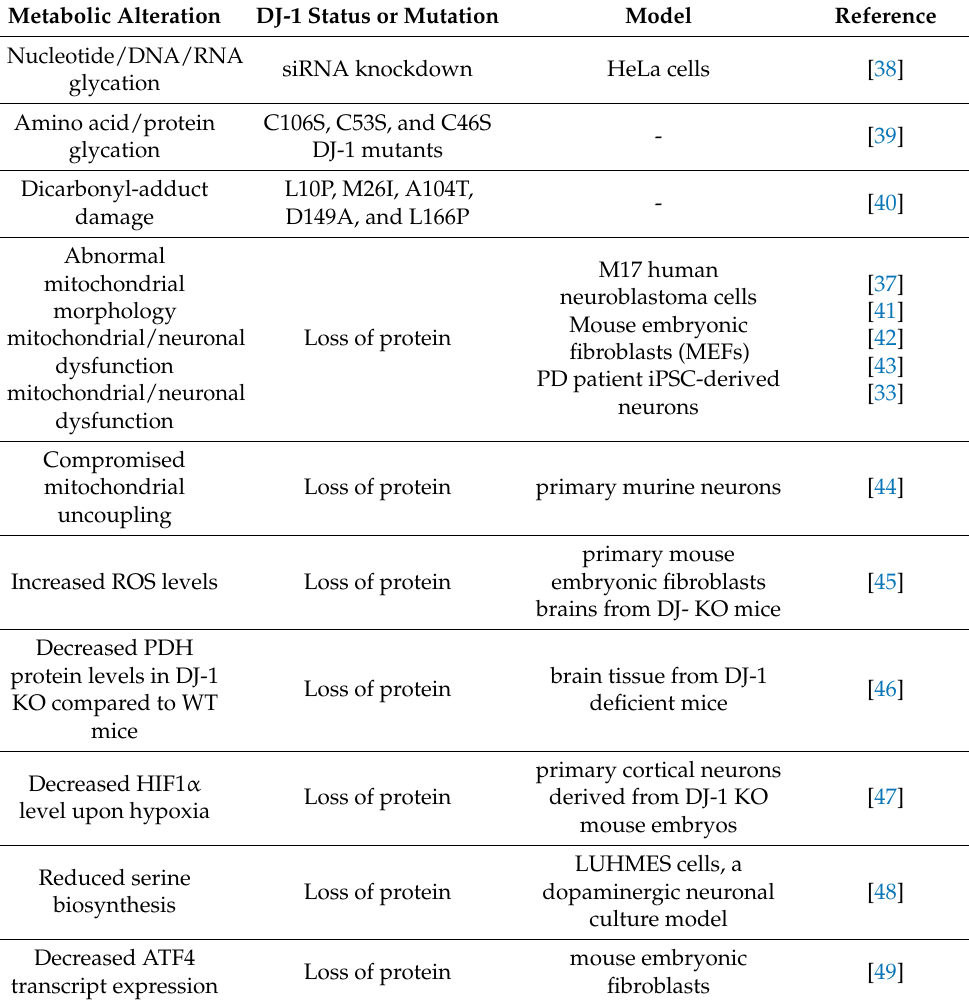
Table 1. Overview of metabolic alterations depending on DJ-1